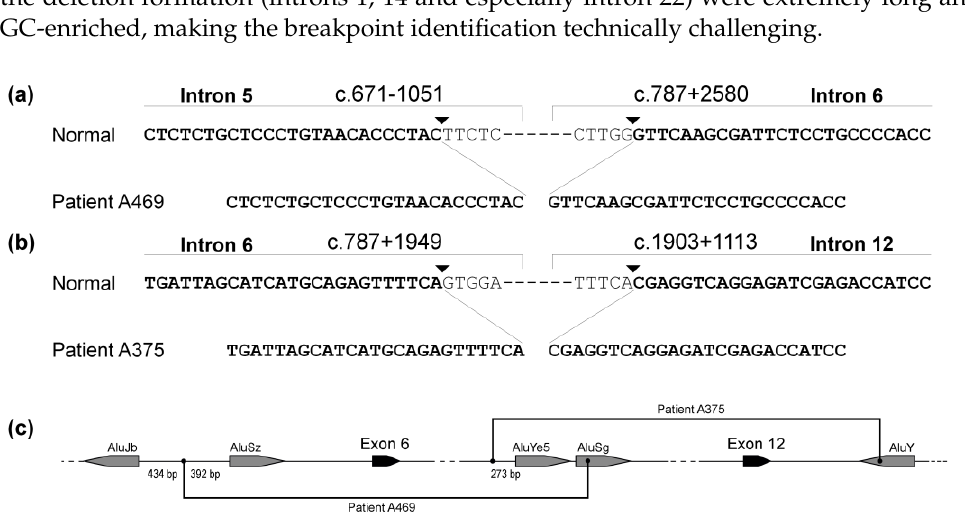
Figure 2. Breakpoints for two large deletions: ( a ) Deletion of exon 6; ( b ) Deletion of exons 7 – 12; ( c ) Locations of established breakpoints relative to adjacent Alu